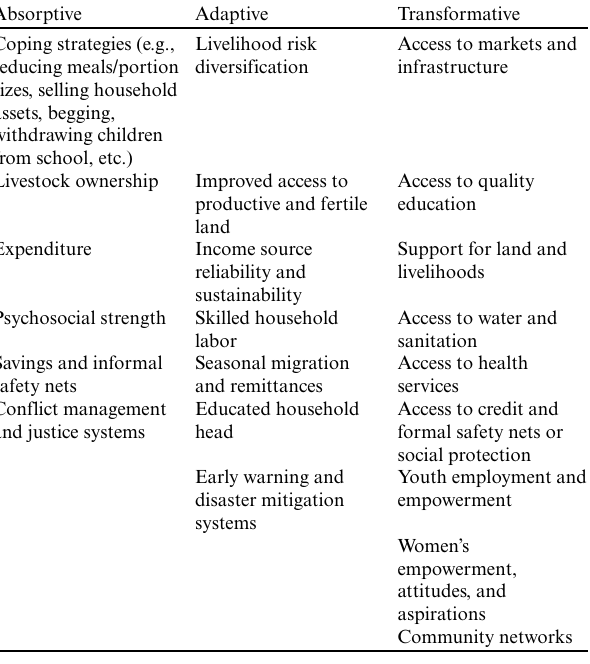
Table 1 . Absorptive, adaptive, and transformative capacities identified for South Sudan in the World Food Program’s resilience context analysis (2015).